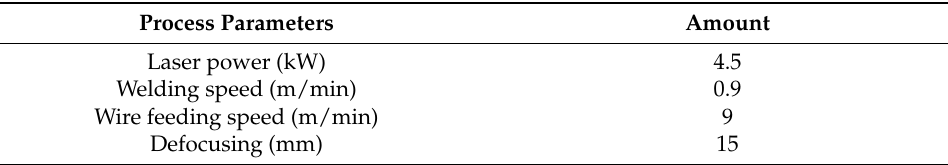
Figure 2. ( a , c ): the schematic diagram of the NGLW process; ( b ) the NGLW experimental equip- Table 3. The welding parameters of the NGLW ment. Table 3. The welding parameters of the NGLW process.